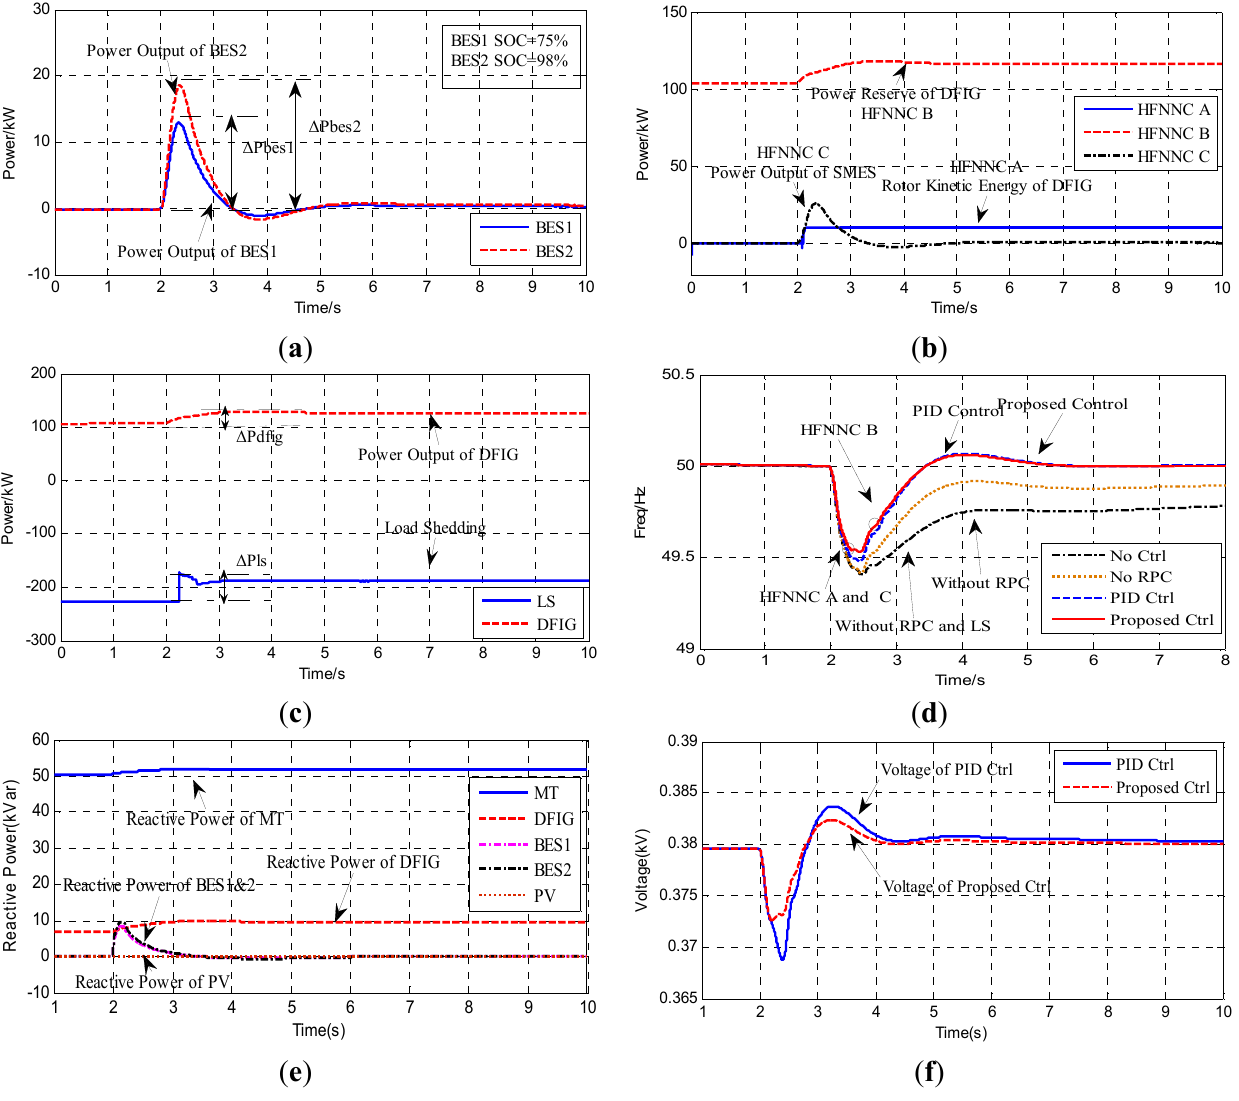
Figure 9. Control performance with the proposed control scheme in case B. ( a ) Active power outputs of BESs by SOC control; ( b ) Active power outputs of DFIG-SMES by HFNNC control; ( c ) Active power outputs of DGs; ( d ) Frequency responses of different control methods; ( e ) Reactive power outputs of DERs; ( f ) Voltage responses of different control